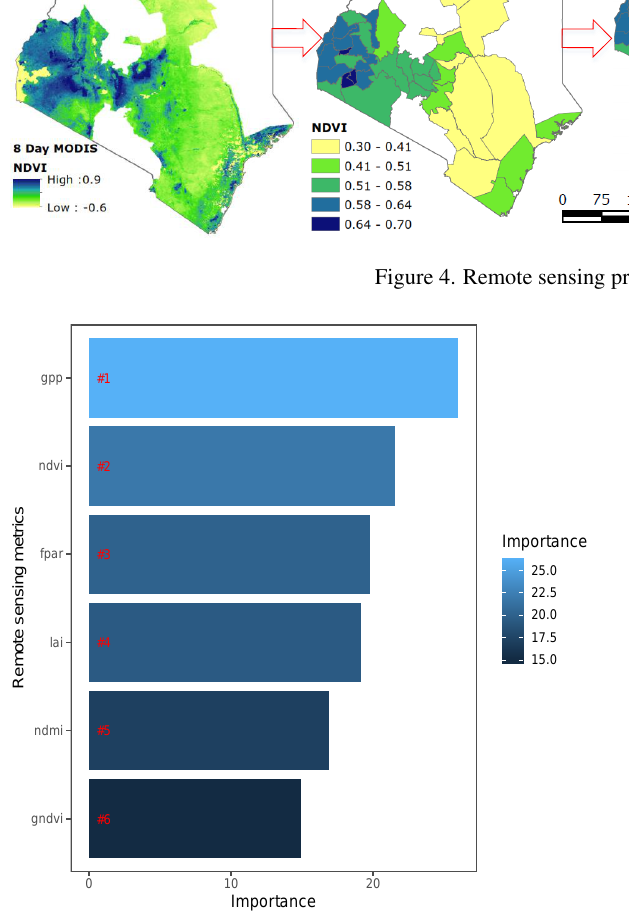
Figure 6. Relationship of RS metrics with maize yields over 2010–2017 period.